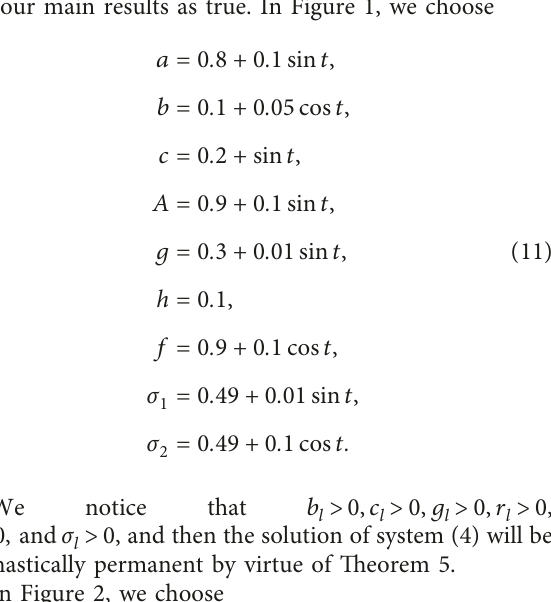
Figure 2: Solution is stochastically permanent if b